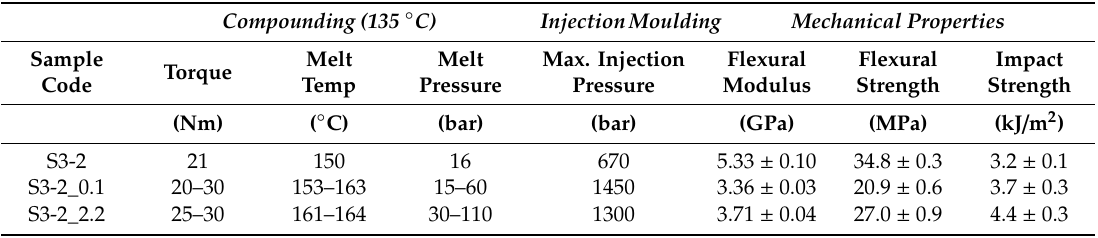
Table 6. Recorded processing parameters for the compounds, and mechanical properties of the green bodies of Series 3.